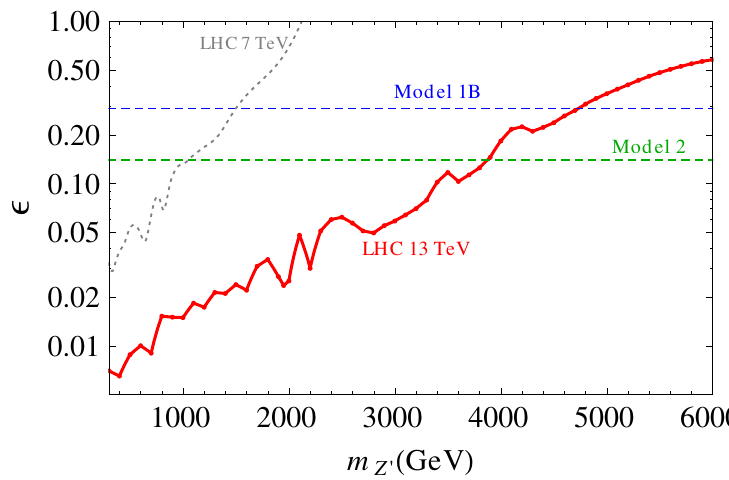
Figure 3 . Our computation of the experimental bound on the kinetic mixing parameter (cid:15) as a function of the Z 0 mass. In solid red our results based on the 13 TeV ATLAS analysis [111] are shown. In dashed gray we show for comparison the 7 TeV exclusion bound derived in ref. [89]. Dashed blue and green line indicate the predictions of Models 1B and 2,